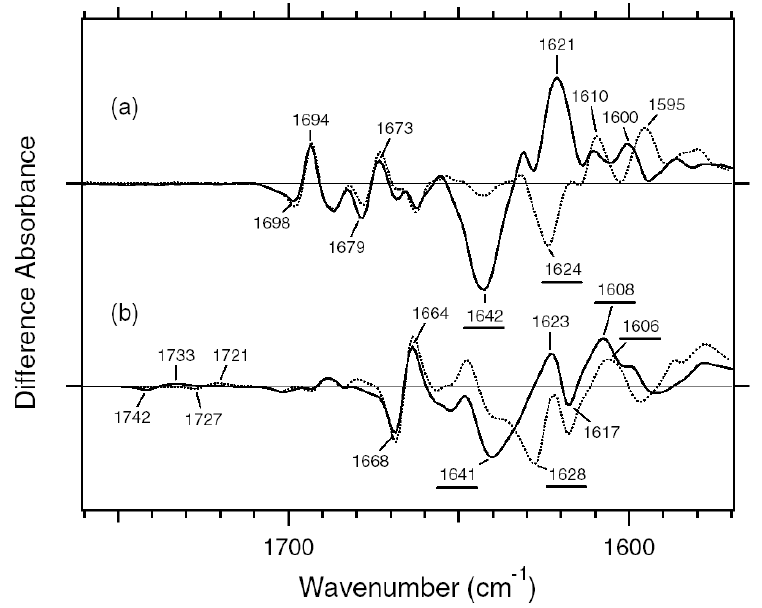
Figure 10. The ASR minus ASR (a) and the BR minus BR (b) spectra in K K the 1,760–1,570 cm -1 region, most of which are ascribable for vibrations of the protein moiety. The underlined peaks are C=N stretching vibrations of the chromophore. The sample was hydrated with H O (solid lines) or D O (dotted lines). One division of the y-axis 2 2 corresponds to 0.003 absorbance units. This figure is reprinted with permission from Furutani et al. [20]. Copyright 2005 American Chemical